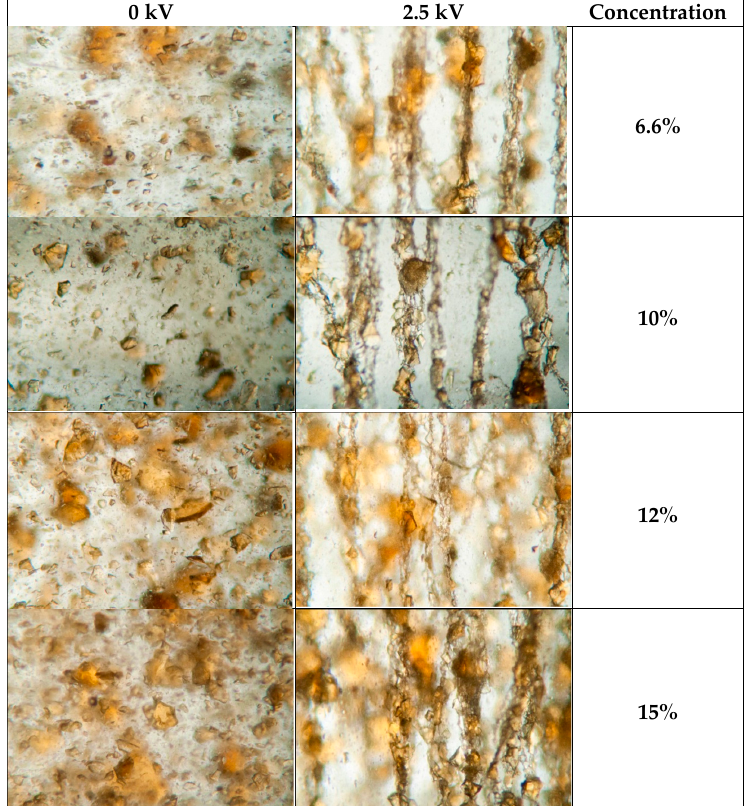
Figure 4. Micrographs of suspensions of polyimides without a field ( left ) and with a field of 2.5 kV ( right ) (scale 1 mm by the height of the picture).